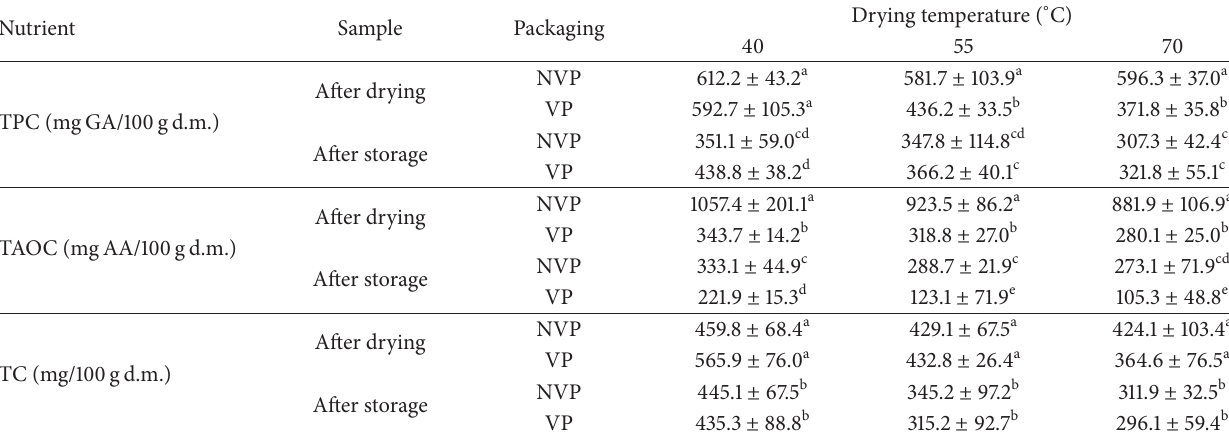
Figure 2: Vitamin C variation during twenty weeks of storage of galega kale dried at 40, 55, and 70 ∘ C, packed without vacuum (NVP) and with vacuum (VP). Bars are limits of standard deviation. Table 2: Concentration of total phenolic content (TPC), total antioxidant capacity (TAOC), and total chlorophylls (TC), obtained for galega kale dried at 40, 55, and 70 ∘ C, after 1 week (after drying) and 20 weeks of storage (after storage), using packaging with vacuum (VP) and without (NVP)